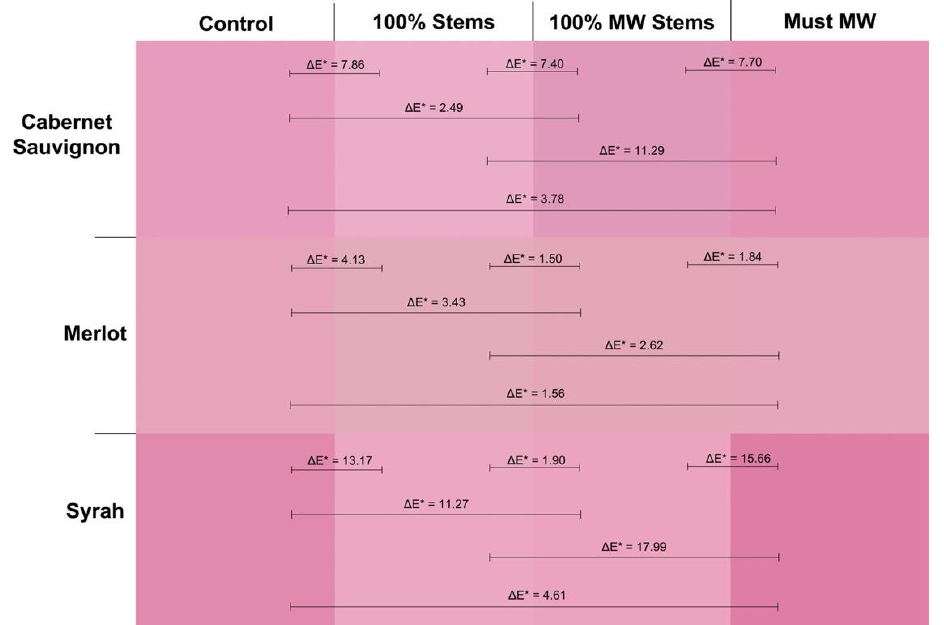
Figure 6. Visual depiction of the actual color of the 2017 wines of the three cvs. and four winemaking treatments as seen through a 1 mm path length quartz cuvette at the time of pressing (day 12). ΔE* values are shown between each pair of treatments for a given cv.